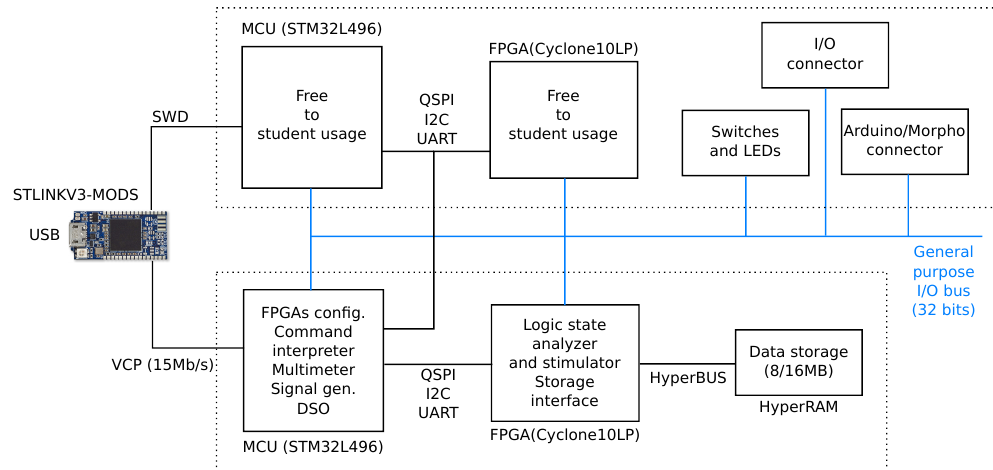
Figure 2. Block diagram of the designed